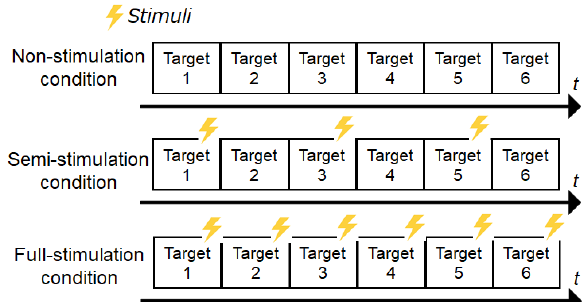
Figure 5. Conditions for stimulus presentation